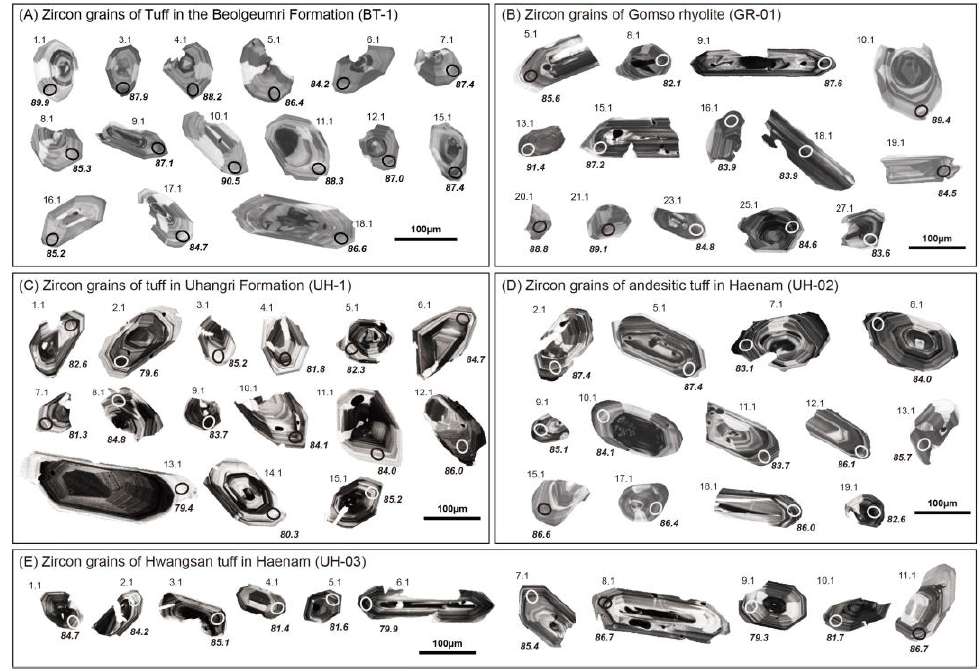
Figure 5. Cathodoluminescence (CL) images of zircon grains from ( A ) the tuff in the Beolgeumri Formation, ( B ) the Gomso Rhyolite, ( C ) the tuff in the Uhangri Formation, ( D ) the andesitic tuff, and ( E ) the Hwangsan Tuff. Analyzed points and ages (bold italics) are shown.